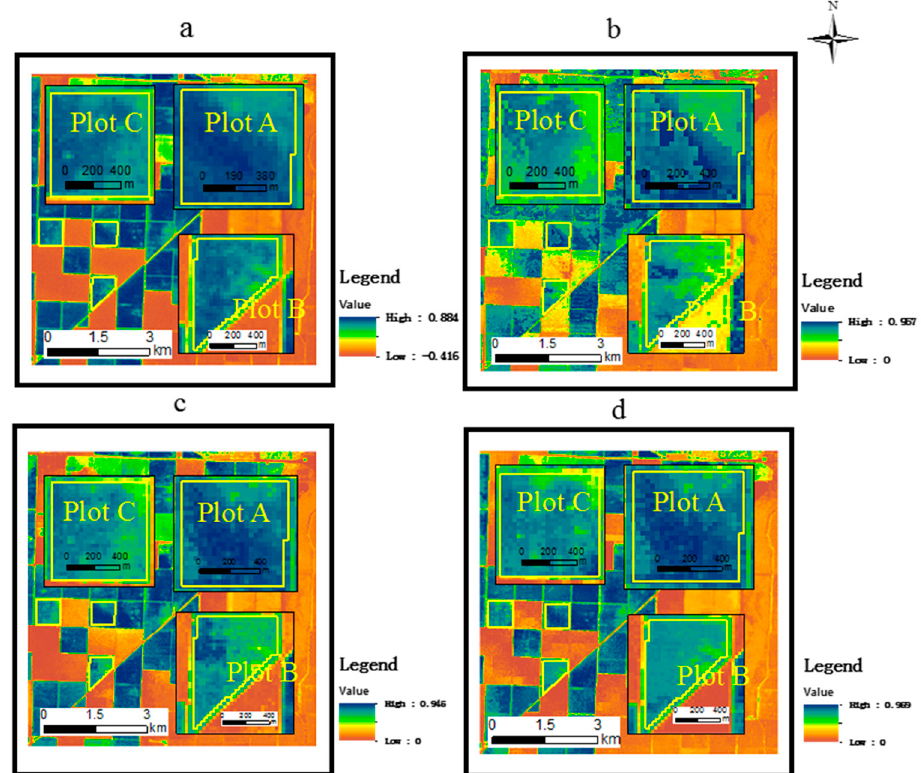
Figure 12. A visual comparison of fusion results; ( a ) Landsat NDVI image on DOY 230; ( b – d ) image on DOY 225 from fusion of MODIS 250 m imagery (NDVI F250_225 ) with reference Landsat images on DOY 174, DOY 206, and DOY 254.